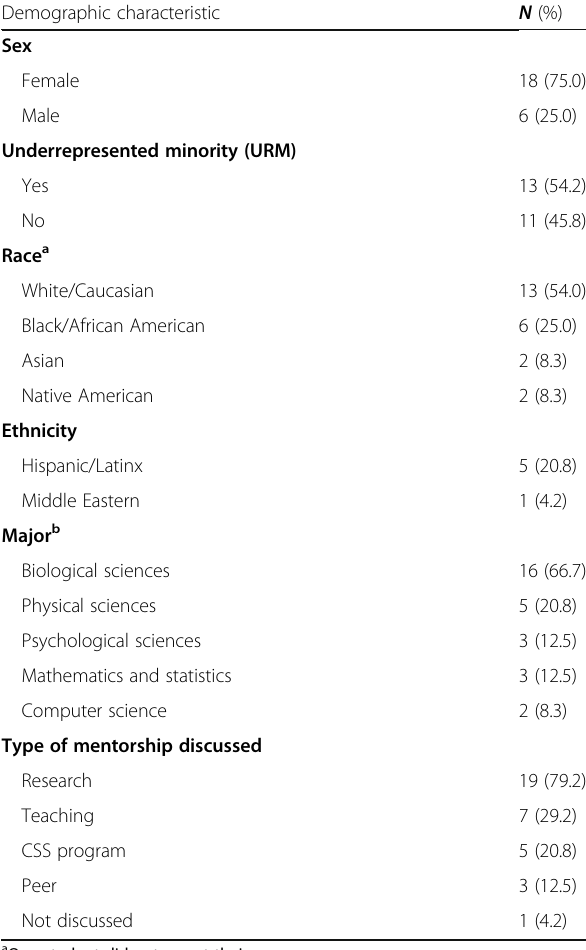
Table 2 Demographic characteristics of sample ( n = 24) Demographic